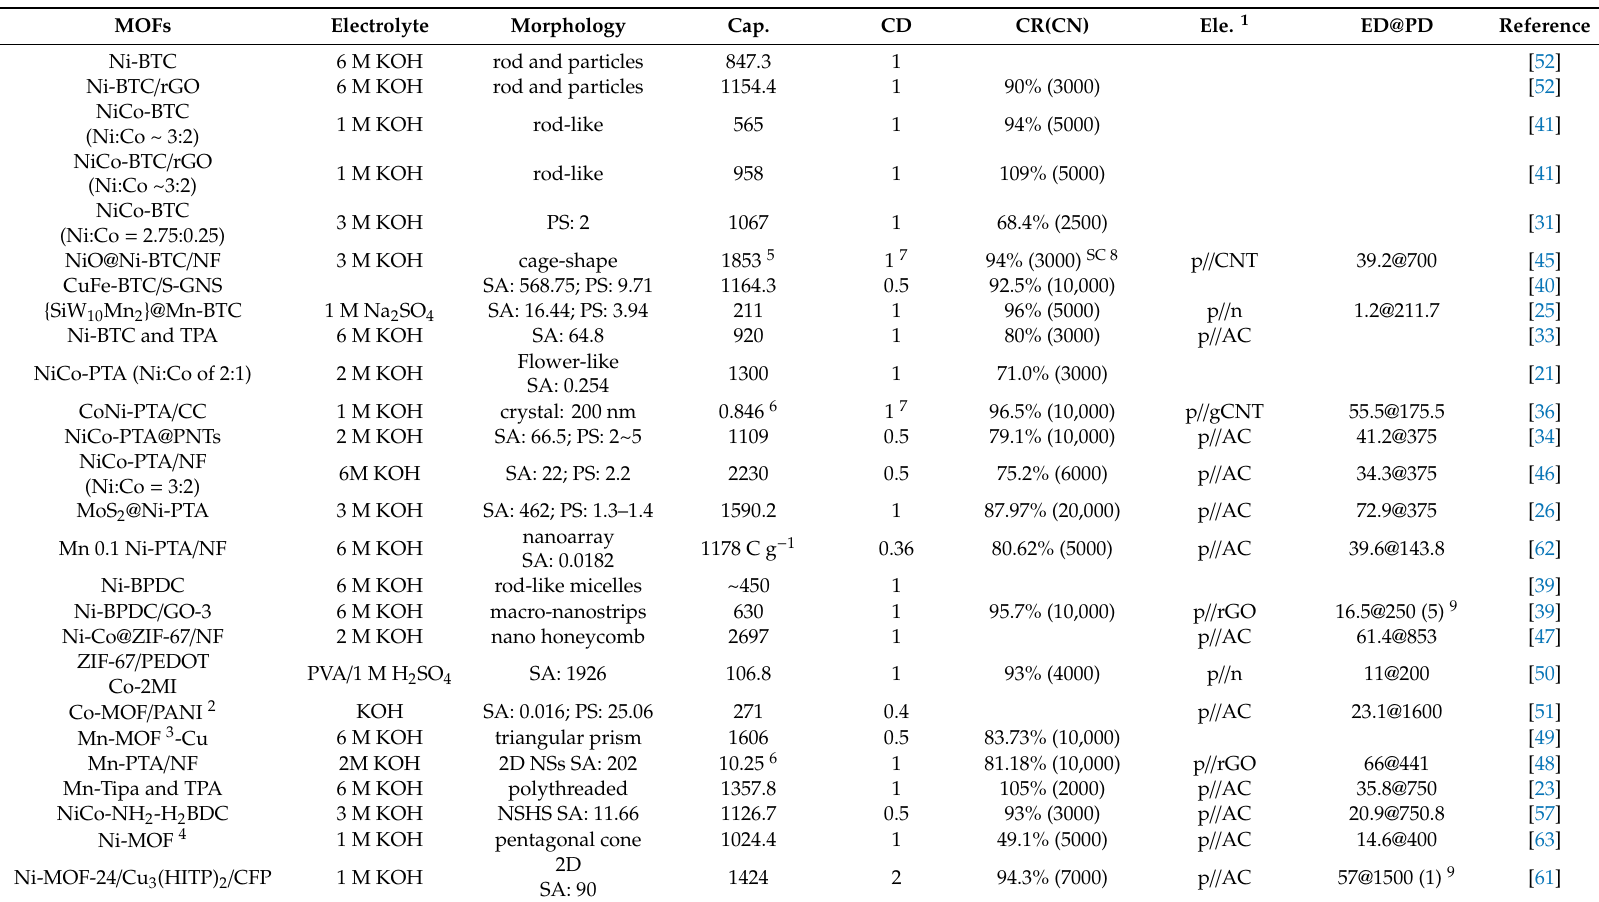
Table 1. Selected MOF-based electrodes for supercapacitor applications. Cap., capacitance (F g − 1 ); CD, current density (A g − 1 ); CR, capacity retention; CN, cycle number; Ele., electrode; ED, energy density (Wh kg − 1 ); PD, power density (W kg − 1 ); SA, surface area (m 2 g − 1 ); PS, pore size (nm). The same below.